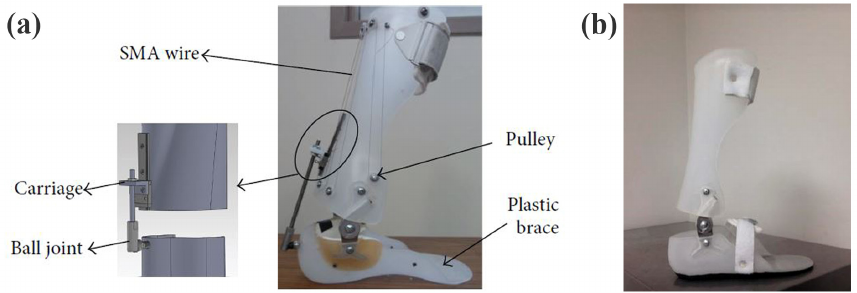
Figure 7. Images of SMA-based AFOs. ( a ) Superelastic-wire-based AFO [78]; with permission from